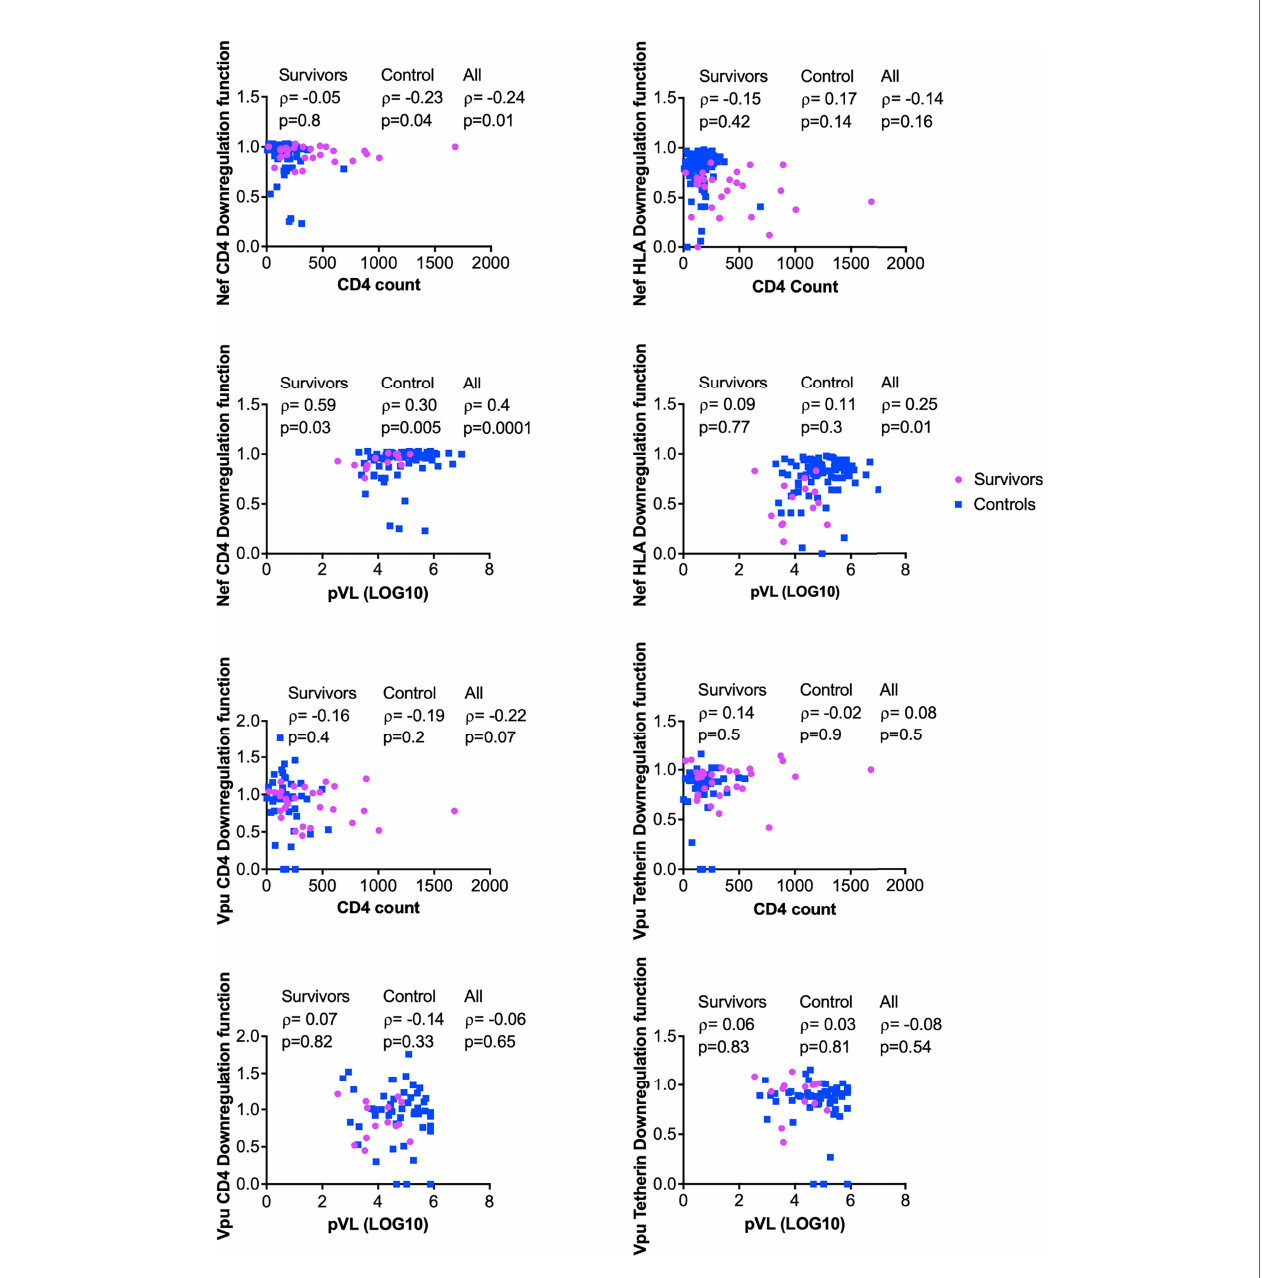
FIGURE 6 | Relationship between Nef and Vpu functions and HIV clinical parameters (CD4 and pVL). Relationships were assessed within survivors, within controls, and in combined cohorts, using Spearman ’ s